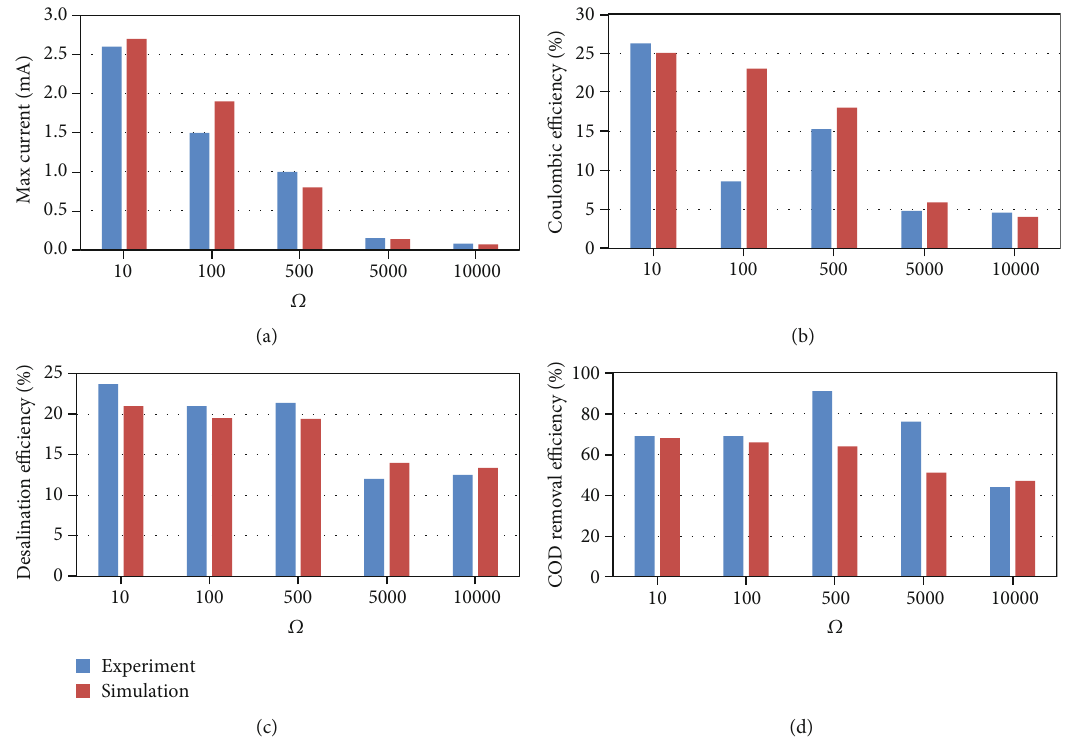
Figure 2: Comparison between model and experimental results at di ff erent external resistances. (a) Max current (mA). (b) Coulombic e ffi ciency. (c) Desalination e ffi ciency. (d) COD removal e ffi ciency. Table 2: Model calibration at di ff erent temperatures. Desalination E ff COD Removal E ff . %